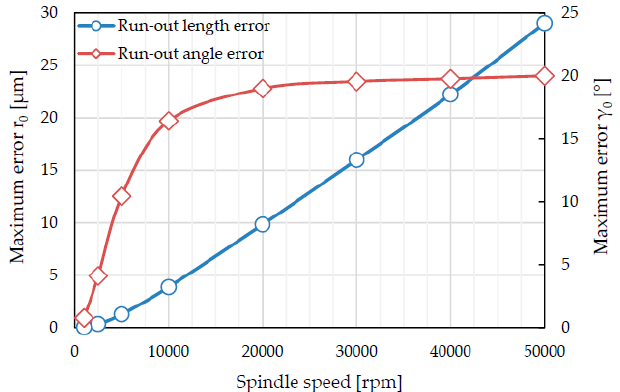
Figure 7. Errors in estimating the tool run-out parameters as a function of the spindle speed (d = 800 μm; r 0 = 3 μm; γ 0 = 20°; sampling rate = 50 kHz).